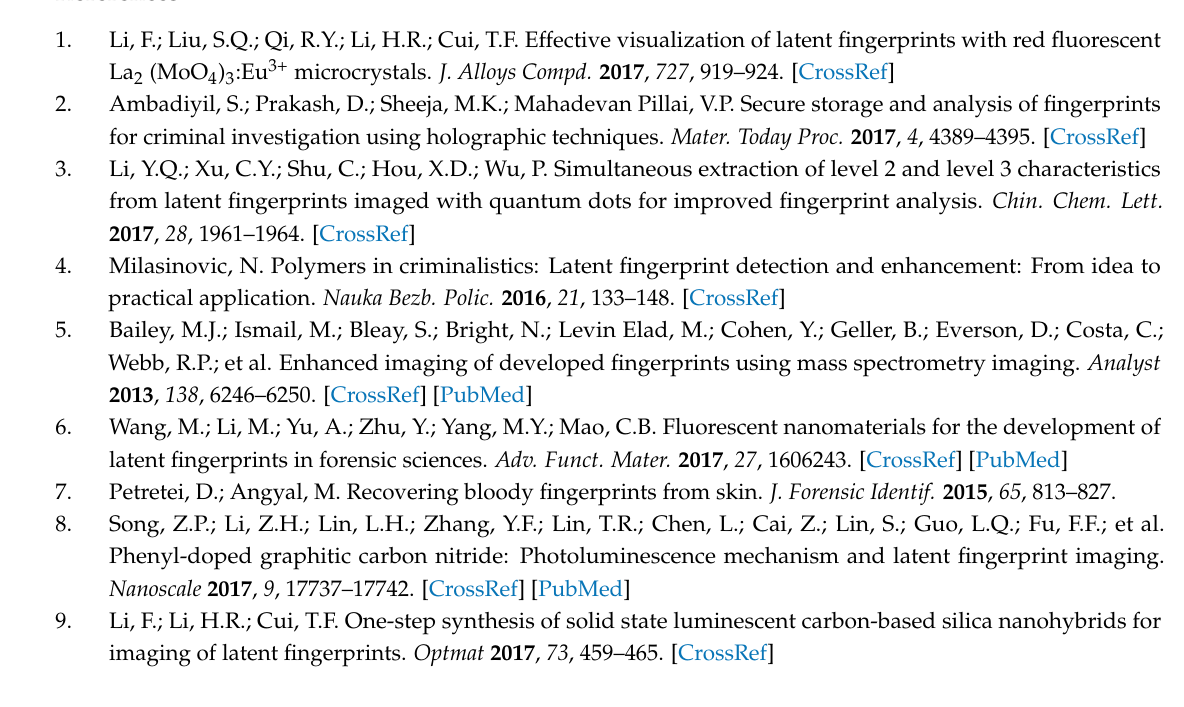
Figure S1: Fluorescence decay curve of green-emissioned carbon dots (G-CDs); Figure S2: Fluorescence spectra of G-CDs and B-CDs at different excitation wavelengths. (a) G-CDs; (b) B-CDs; Figure S3: Diagrams of fingermarks on the tin foil paper developed by various quantum dots (QDs). (a) Blue-emissioned carbon dots (P-B-CDs); (b) Yellow-emissioned carbon dots (Y-CDs); Figure S4: Fluorescence properties by G-CDs of various pH values; Figure S5: FTIR spectrum of the